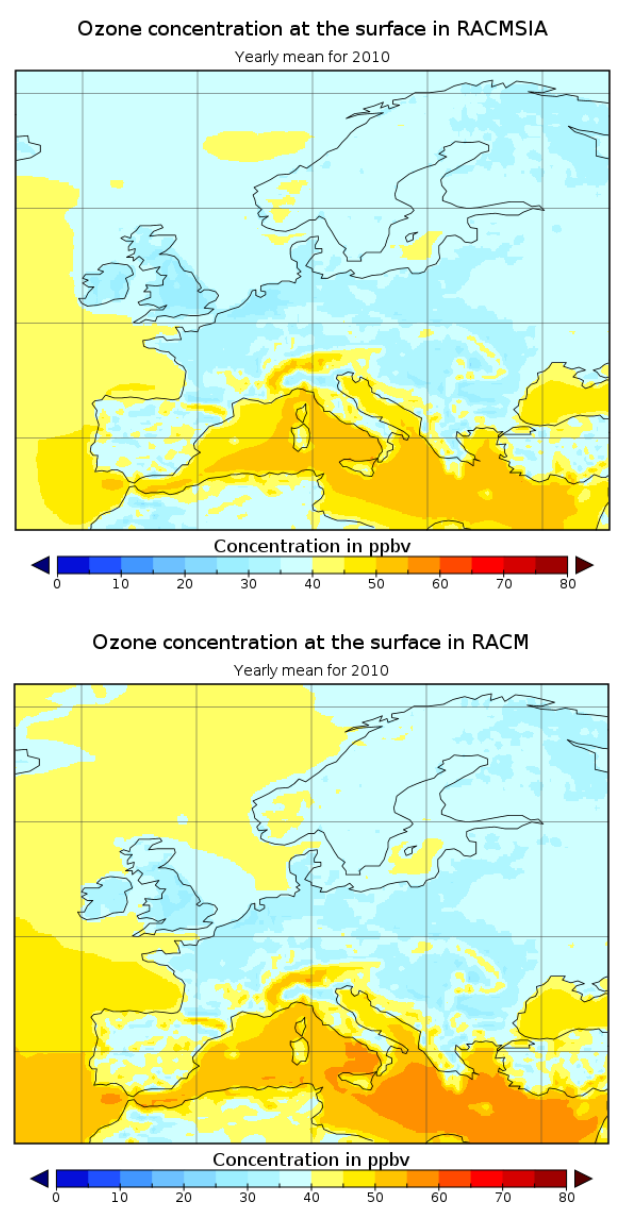
Figure 12. Maps of regional annual mean ozone concentrations for the year 2010 in ppbv. The top panel represents the RACMSIA sim- ulation and the bottom panel the RACM simulation.